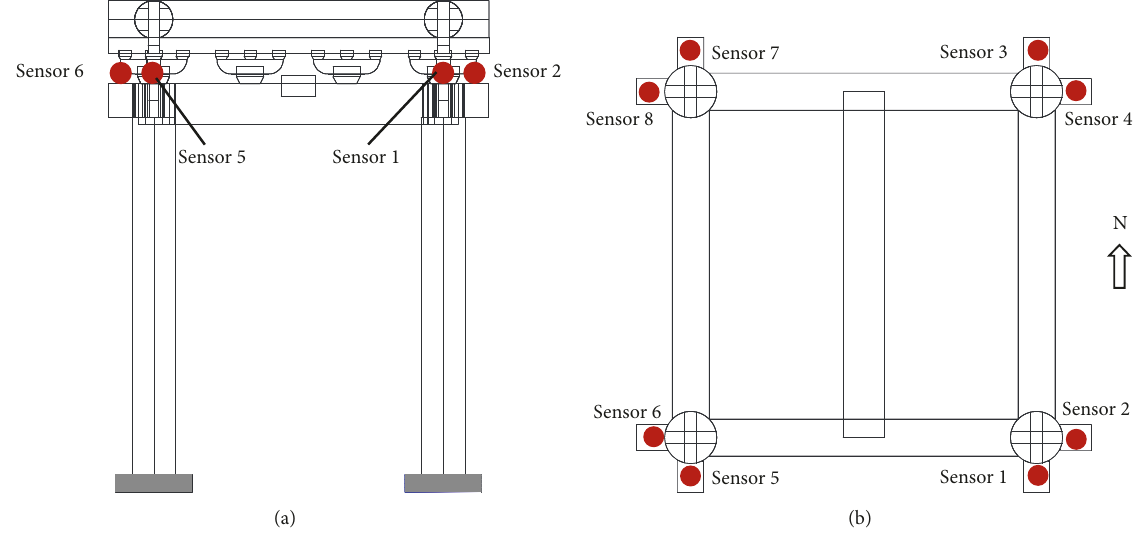
Figure 18: Arrangement of sensors: (a) elevation view; (b) plan view.